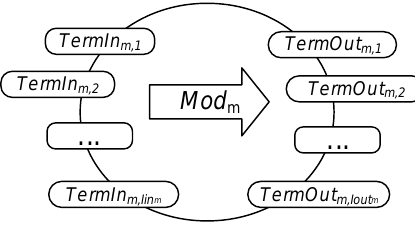
Fig. 1. Module as an operator for converting input terms to output